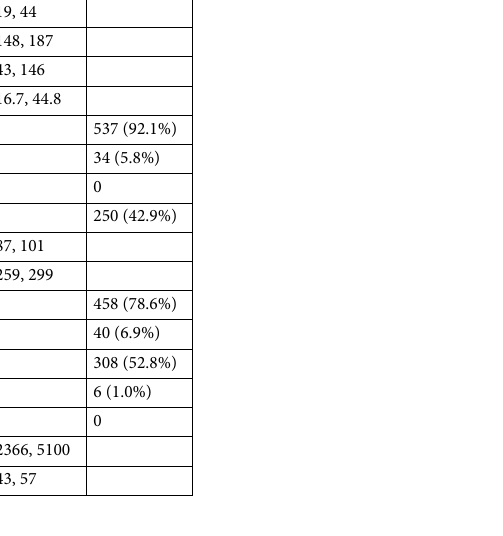
Table 1. Maternal and neonatal